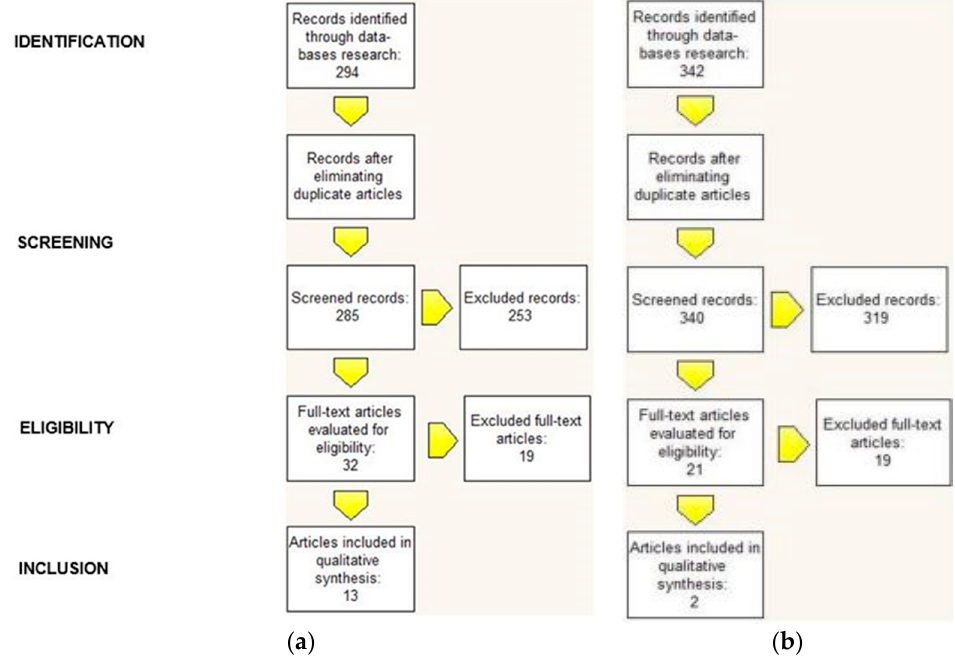
Figure 1. ( a ) Correlation between Eagle Syndrome and traumatic events; ( b ) Correlation between Eagle Syndrome and extractive dental events.